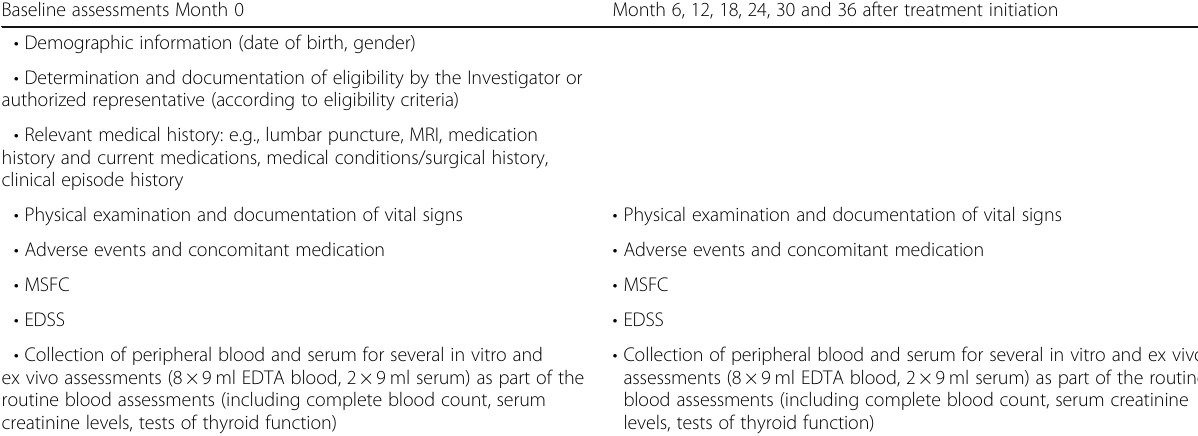
Table 1 Regular Study Procedures Baseline assessments Month